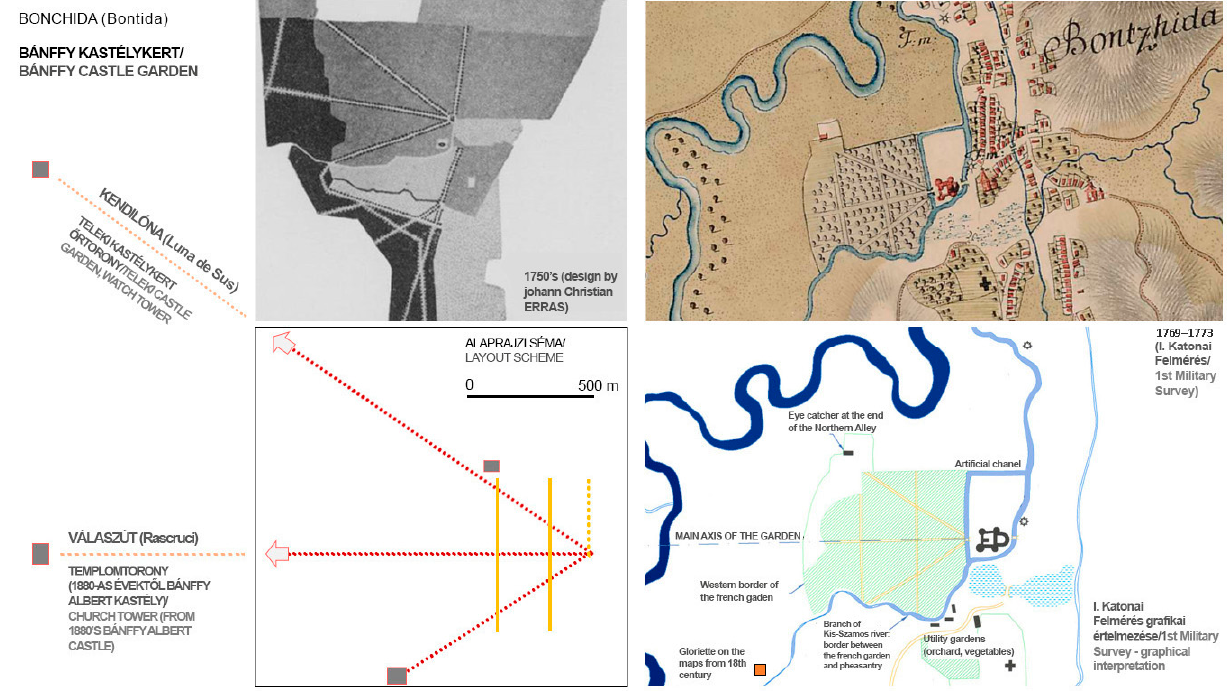
Figure 3. Map-based analysis of the goosefoot-pattern Baroque garden in Bonchida.